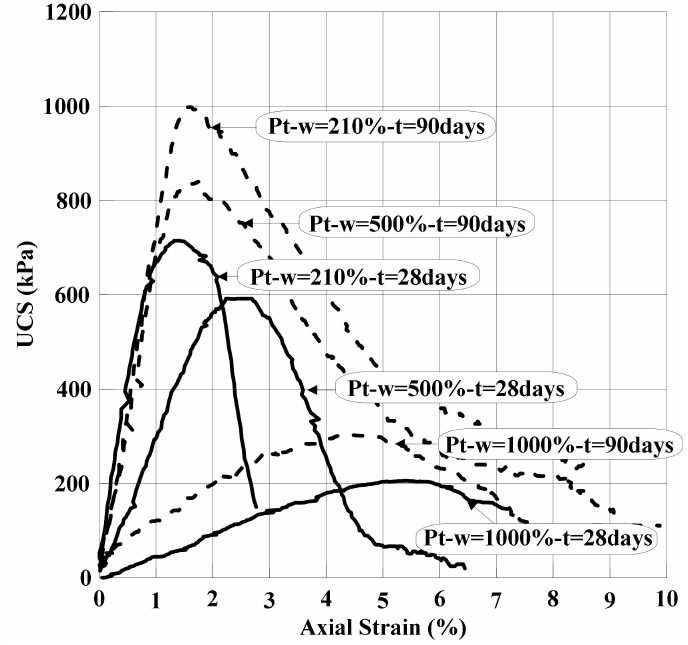
Figure 13. Effect of curing time on Pt-PC samples at 28 days and 90